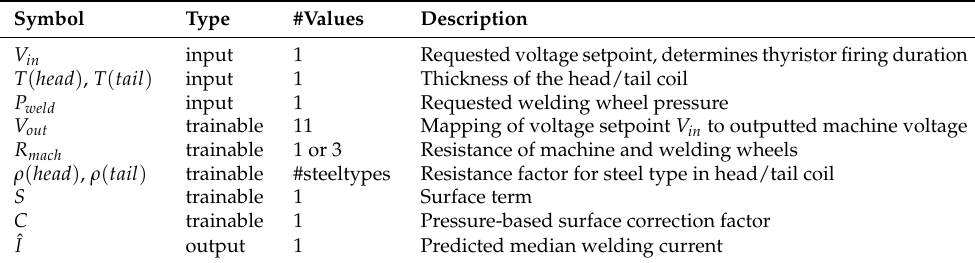
Table 1. Overview of the parameters of the welding current prediction model.